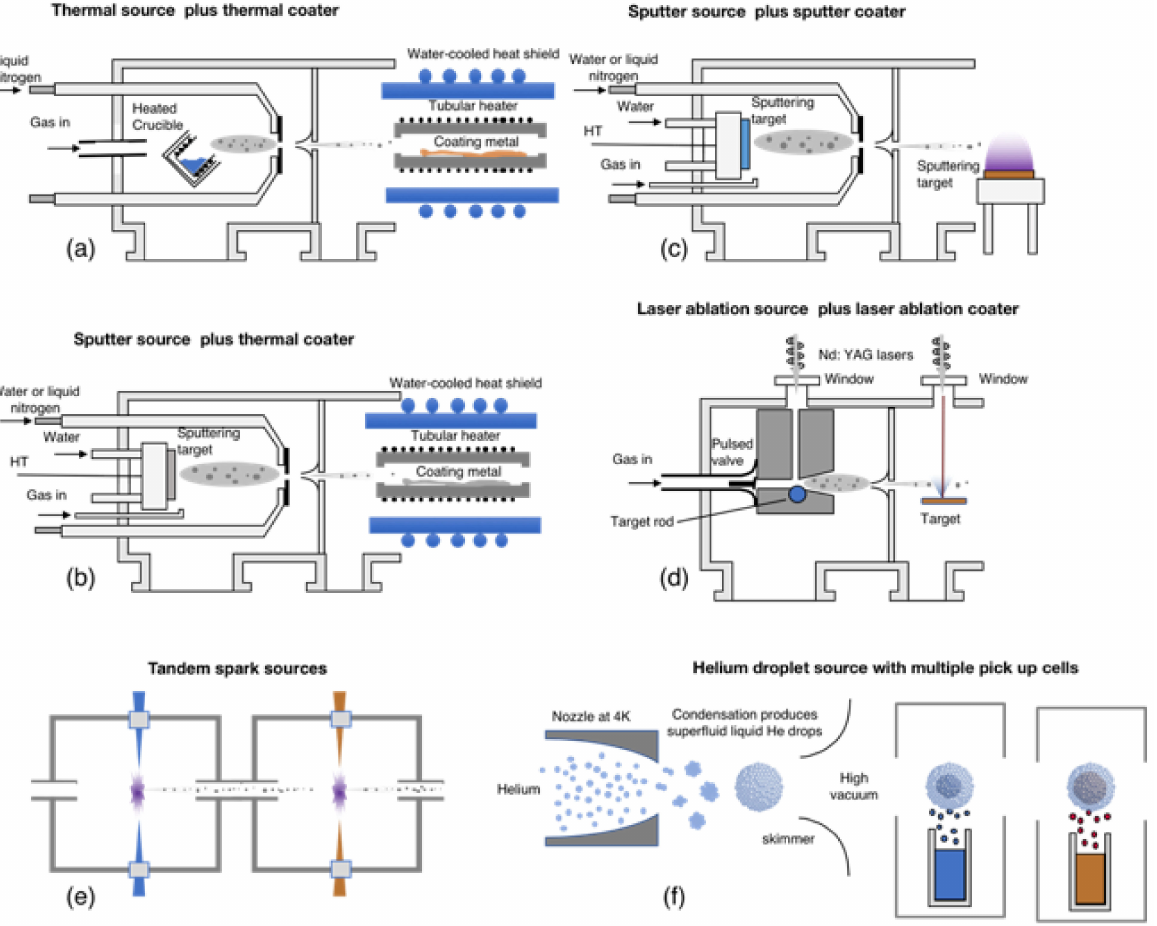
Figure 3. Sequential methods for producing core–shell nanoparticles. ( a – e ) are all “hot” coating techniques, that is, the shells are coated onto the core nanoparticles in a high energy environment in which the core nanoparticles are heated. ( f ) Core–shell particles produced by condensation of metal vapor within liquid He droplets, which is a “cold” coating